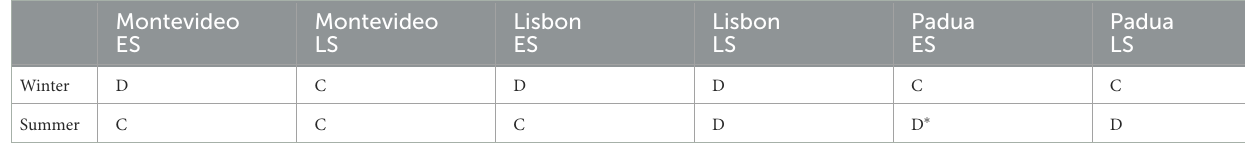
TABLE 5 Summary of the types of comfort during winter and summer for each population, where C- Comfort and D-